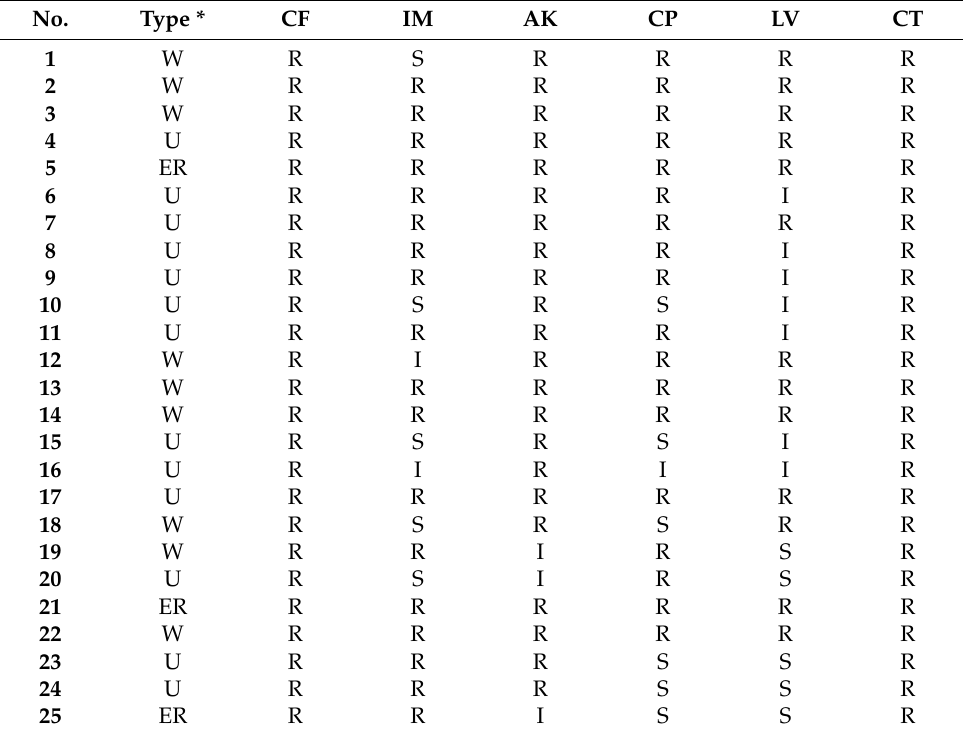
Table 1. Antibiotic resistance patterns of the tested P. aeruginosa strains.